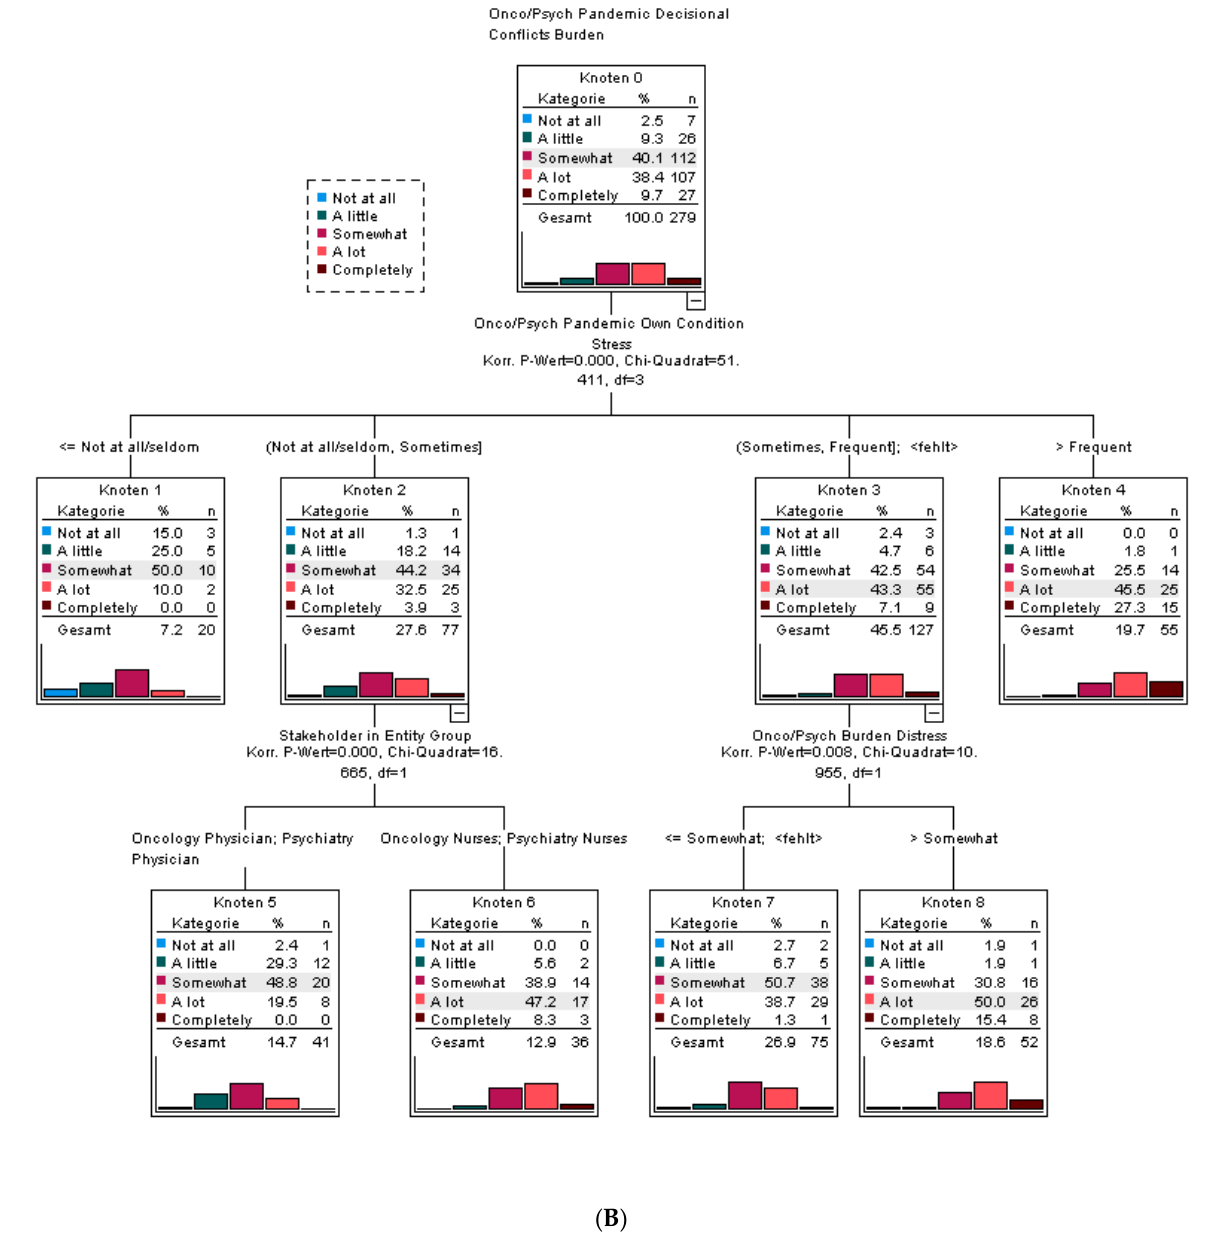
Figure 5. Tree classification for parameters influencing ( A ) “Decisional Uncertainty” and ( B ) “Deci- sional Conflicts”.